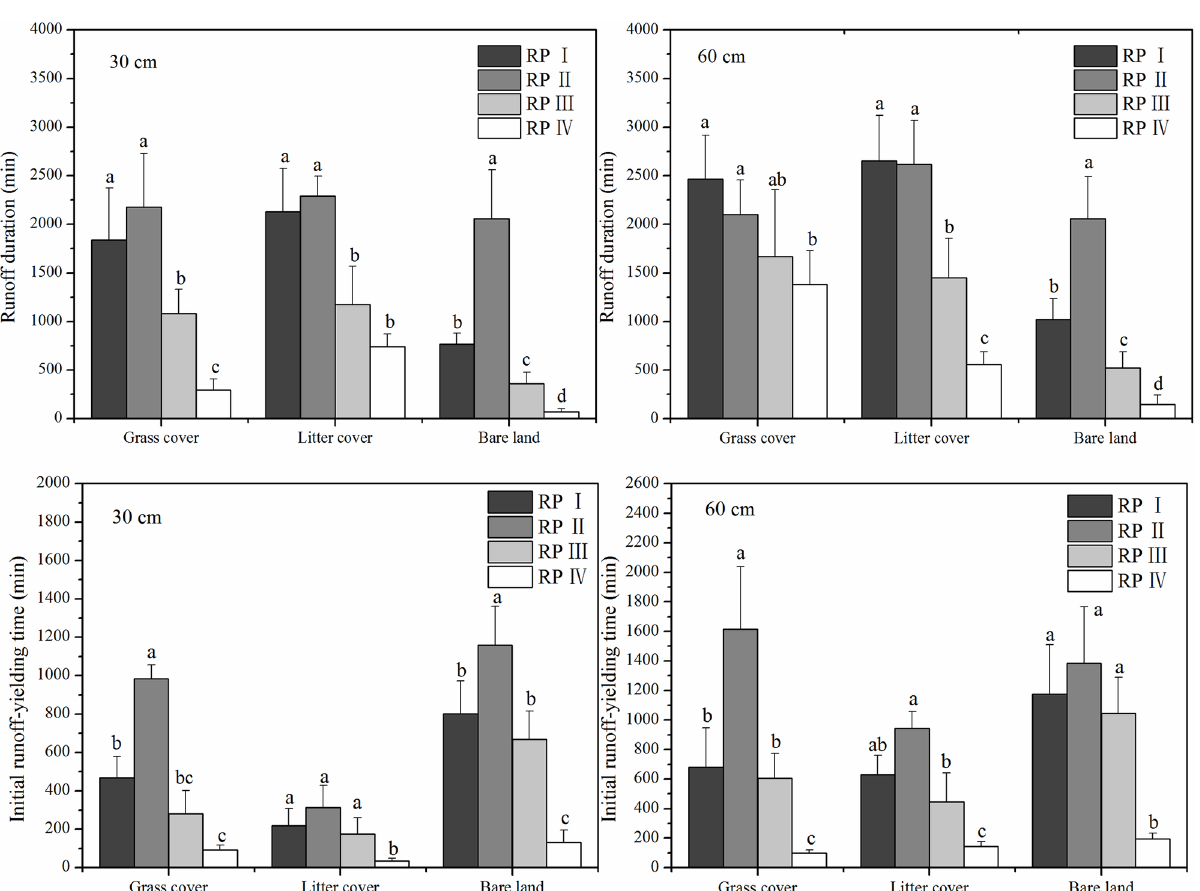
Fig 8. Runoff duration and initial runoff yield time for subsurface flow generation under different rainfall patterns.